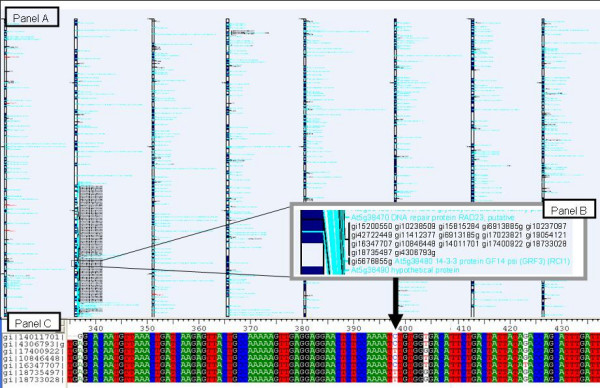
Panel (A) A Synteny map of soybean sequences compared to A. thaliana genomic sequence. The region displayed is from A. thaliana chromosome V, 15,000,000 – 17,250,000 bp. Solid chromosomal segments represent reported A. thaliana genes, described in light text. All "gi" features are soybean ESTs, All "H" or "B" features represent bacterial artificial chromosome (BAC) end sequence. Map display created in MapChart and exported in enhanced metafile format. Each vertical segment is equivalent to 250,000 bp of A. thaliana DNA. Panel (B) is an expanded view of the 15,400,000 to 15,500,000 bp region. Panel (C) is a Clustal alignment of soybean ESTs (gi #'s) listed in Panel b. Varieties listed are: gi14011701 (Williams 82); gi4306793 (Williams); gi17400922 (PI 567374); gi10846448 (Williams 82); gi16347707 (Williams); gi18735497 (Jack); gi18733028 (Raiden). Single nucleotide polymorphisms are apparent at base pair locations 337, 398, 404 and 423 in panel C.